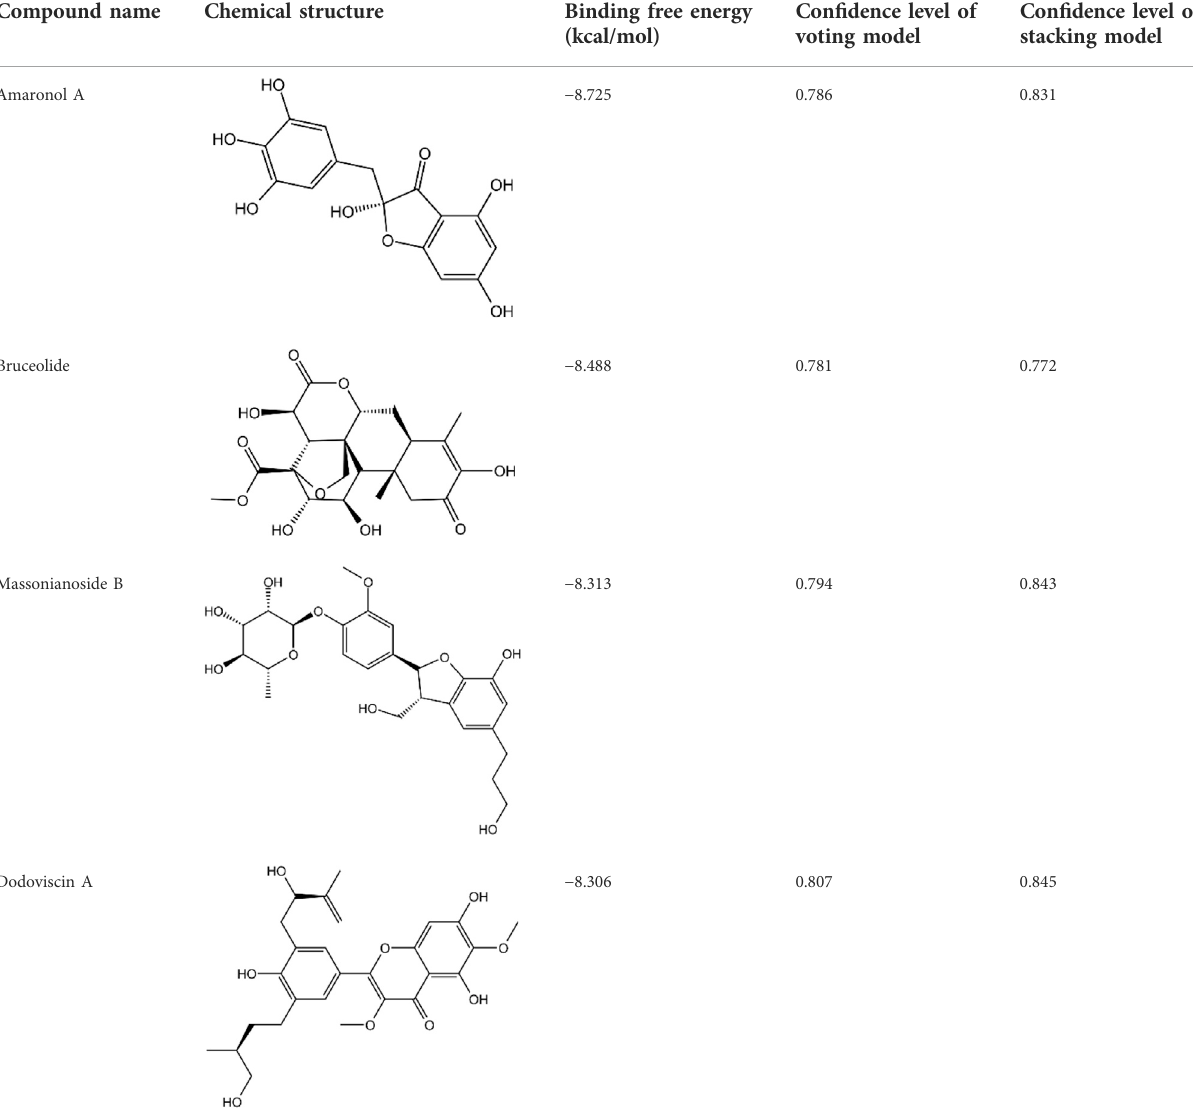
TABLE 2 Details of 4 potential ERK2